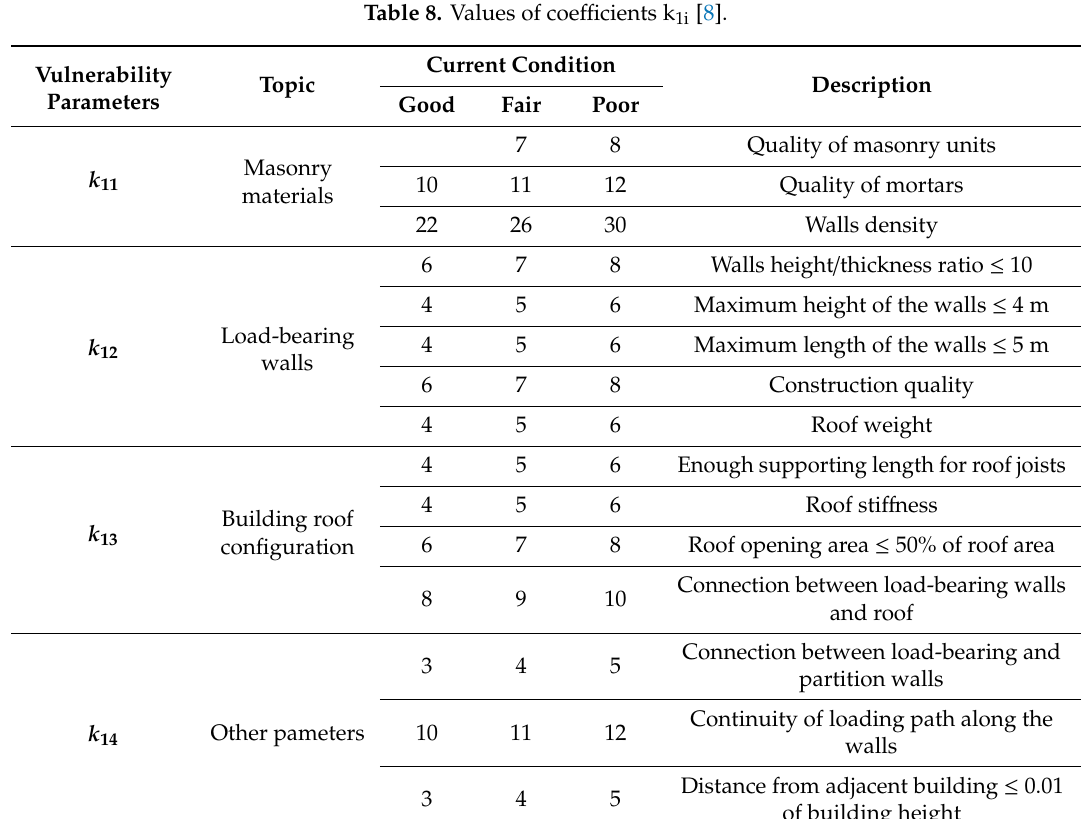
Table 8. Values of coe ffi cients k 1i